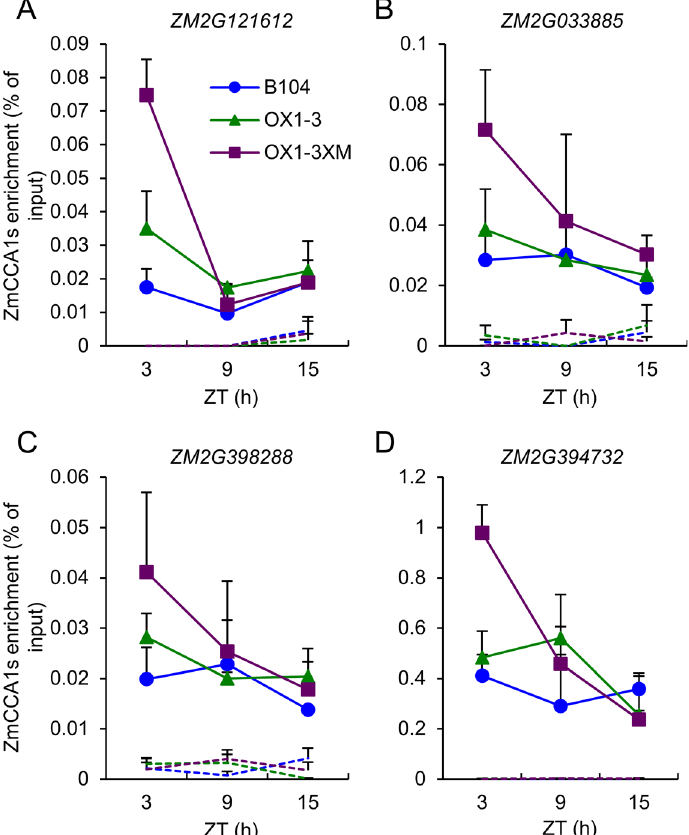
Fig 7. Temporal shift of ZmCCA1-binding to target (carbon fixation) genes in ZmCCA1b overexpression line ( OX1-3 ) and F1 hybrids. (A-D) ChIP-qPCR assays were performed on ZmCCA1-binding target genes in B104, OX1-3 and F1 hybrid ( OX1-3 XMo17) lines in four target genes, ZM2G121612 (A), ZM2G033885 (B), ZM2G398288 (C), and ZM2G394732 (D). ChIP-qPCR values are represented relative to the corresponding input values (means ± SEM, n = 2 – 3). Dash lines represent ChIP- qPCR data from control (mock)